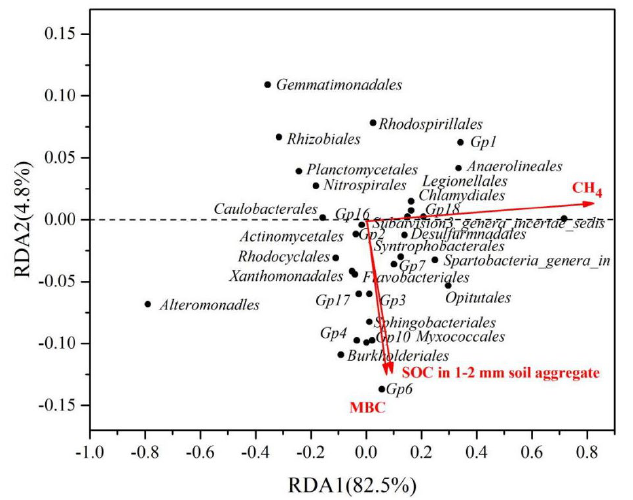
Figure 3. Redundancy analysis (RDA) ordination plot showing changes in bacterial community composition in 0–5 cm soil layer at order level (relative abundance > 0.5%) during the 2013 rice season and 2014 wheat season. SOC, soil organic C; MBC, microbial biomass C.